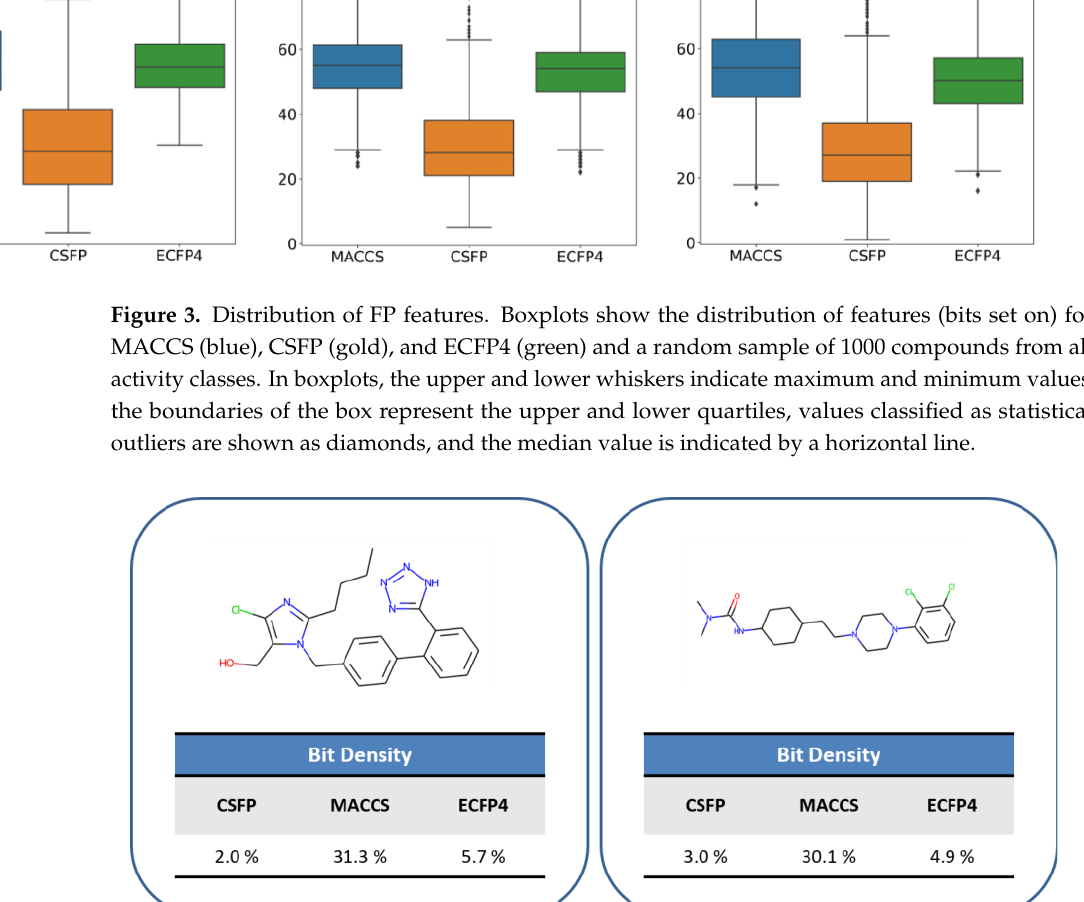
Figure 4. Comparison of FP bit density. For two exemplary compounds, the bit density (percentage of bits set on) of CSFP, MACCS, and ECFP4 is reported.